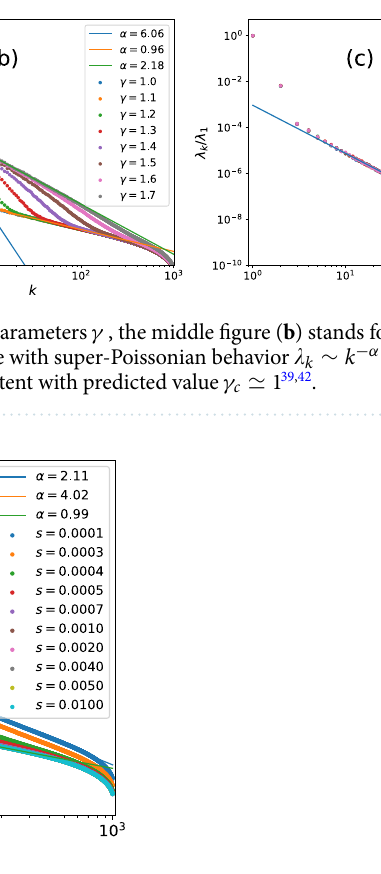
Figure 5. Scree plots of the sparse RM. Clear super-Poissonian behaviors appear, indicating there is NEE regime in this model as well, and the ergodic-NEE transition point is identified to be s c